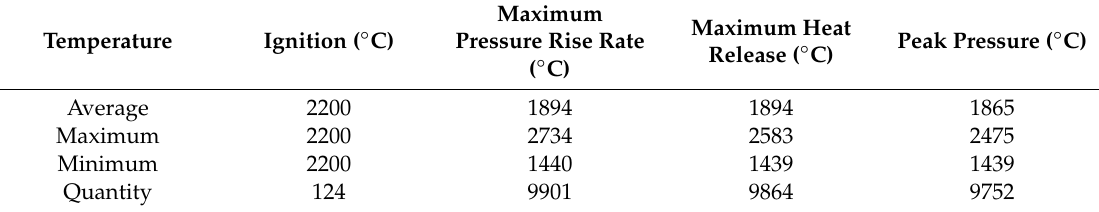
Table 1. Typical temperature of series 1 with MATLAB.